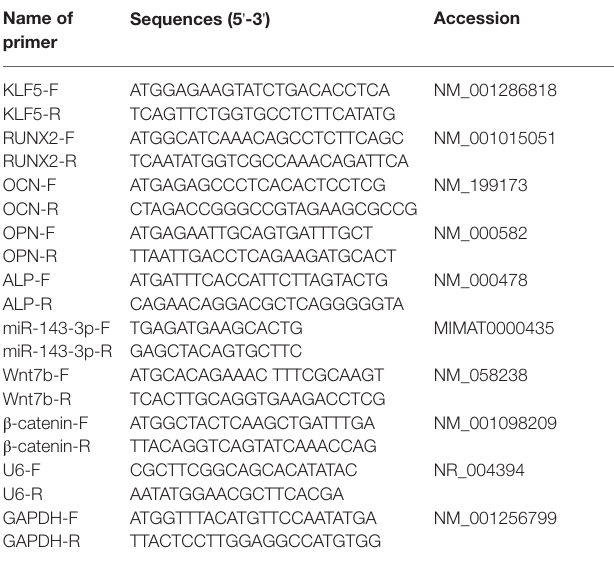
TABLE 1 | Primer sequence for